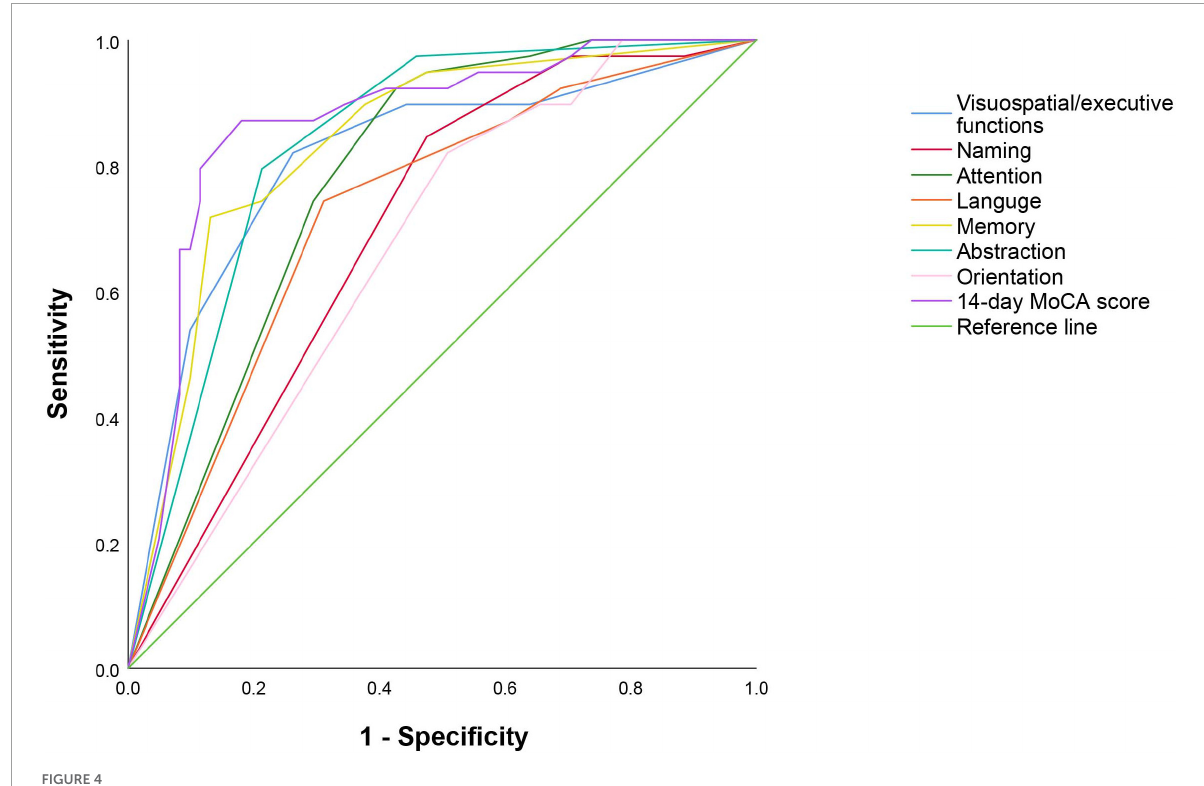
FIGURE4 Receiver operating characteristic curve on predicting PSCI.